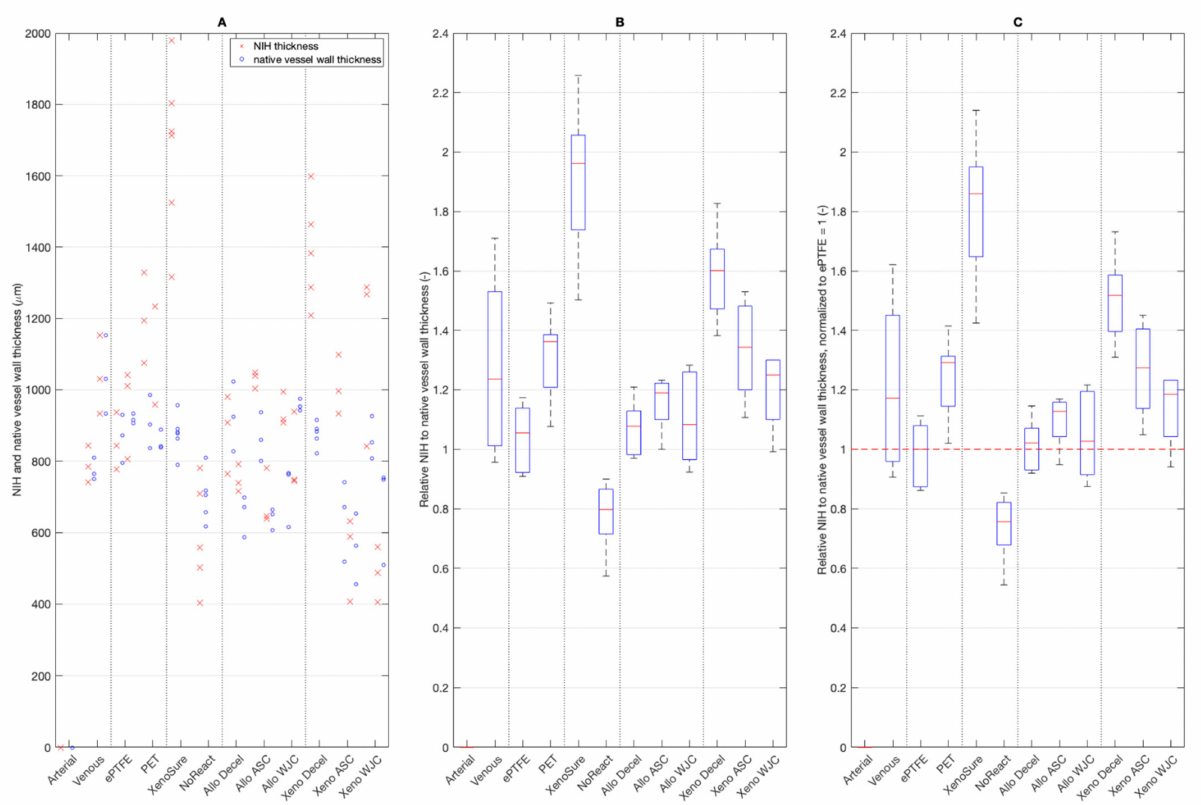
Figure 11. ( A ) Thickness of neo-intimal hyperplasia (NIH) on the control and experimental patches. ( B ) Fold thickness of NIH related to the thickness of the native vessel wall opposite the patch. ( C ) Fold thickness of NIH normalized to that of ePTFE, which was set at 1. Red lines in charts represent median values, blue boxes 1st and 3rd quartiles, and whiskers the minimum and maximum. Note: there was no NIH formation on the arterial autograft. We implanted six types of clinically used vas- cular patches as control grafts, namely two types of autologous patches: arterial autograft (Arterial) and venous autograft (Venous), two kinds of prosthetic patches: expanded polytetrafluoroethylene (ePTFE, Propaten ® Gore ® ) and polyethylene terephthalate (PET, Vascutek ® ), and two types of bio- prosthetic patches: bovine pericardium chemically stabilized with glutaraldehyde (XenoSure ® ) and detoxified porcine pericardium (NoReact ® BioIntegral ® ). We further implanted six types of exper- imental pericardial patches, namely decellularized porcine allograft and ovine xenograft patches (Allo-decel and Xeno-decel, respectively), allograft and xenograft patches recellularized with autol- ogous adipose tissue-derived stromal cells (Allo-ASC and Xeno-ASC, respectively), and allograft and xenograft patches recellularized with Wharton’s jelly mesenchymal stem cells (Allo-WJC and Xeno-WJC,